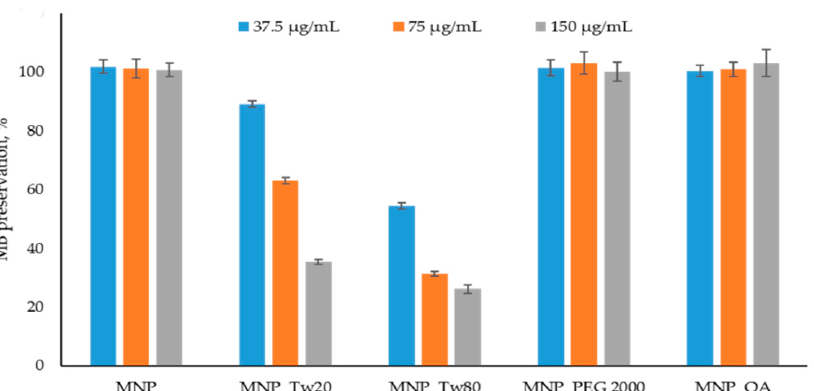
Figure 3. Methylene blue (MB) decolorization assay. The MB degradation % was calculated spec- trophometrically (see Section 3.6). The reactions were carried out using 37.5 µ g/mL, 75 µ g/mL, and 150 µ g/mL MNPs and control solution without nanoparticles. No significant peroxide degradation was obtained in the presence of MNPs.